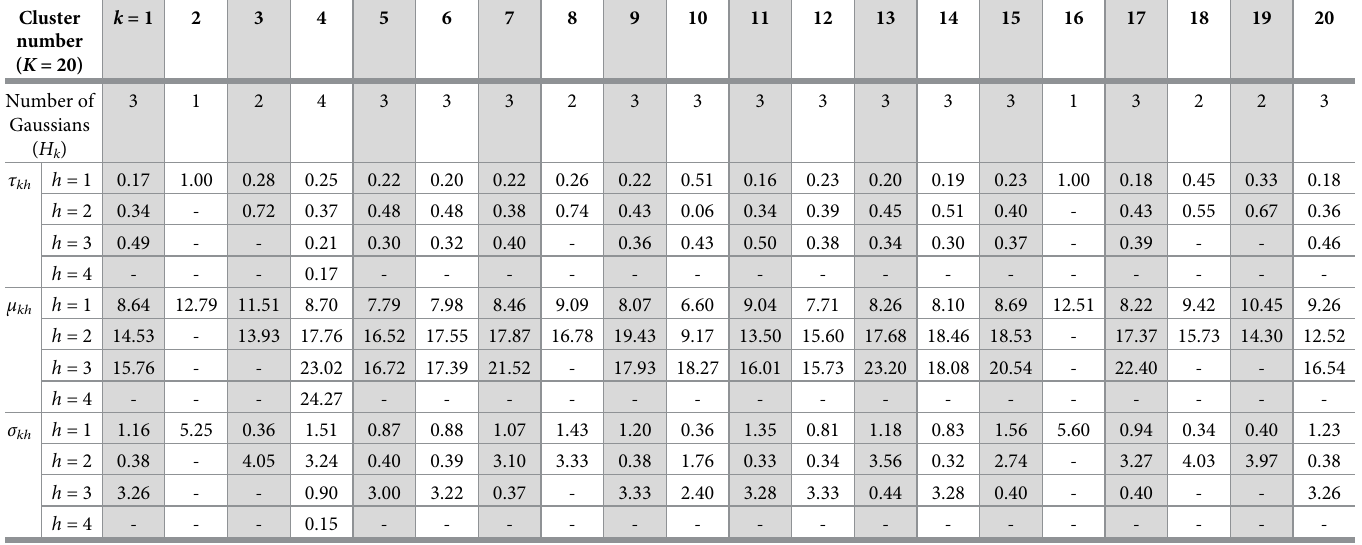
Table 1. Gaussian mixture parameters of the travel pattern for each cluster. Note: The parameter τ kh is the proportion of each distribution, the parameter μ kh is the mean (Gaussian center) of each distribution, and the parameter σ kh is the standard deviation of each distribution. Cluster k = 1 number ( K = 20)